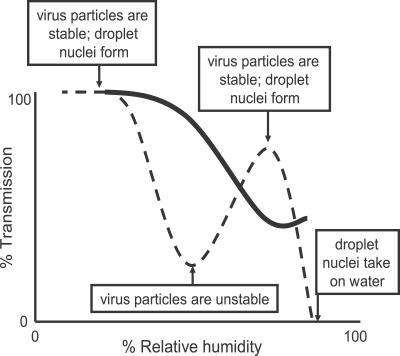
Variation of Transmission Efficiency with Relative Humidity: A ModelAt 20 °C (dashed line), transmission efficiency is highest at low RH, when influenza virions in an aerosol are relatively stable, and desiccation of exhaled respiratory droplets produces droplet nuclei. Transmission is diminished at intermediate RH when virus particles are relatively unstable, but improves in parallel with influenza virus stability at higher humidities. At high RH, evaporation from exhaled particles is limited, respiratory droplets settle out of the air, and transmission is blocked. At 5 °C (solid line), transmission is more efficient than at 20 °C, but is reduced to a rate of 50% at higher humidities.